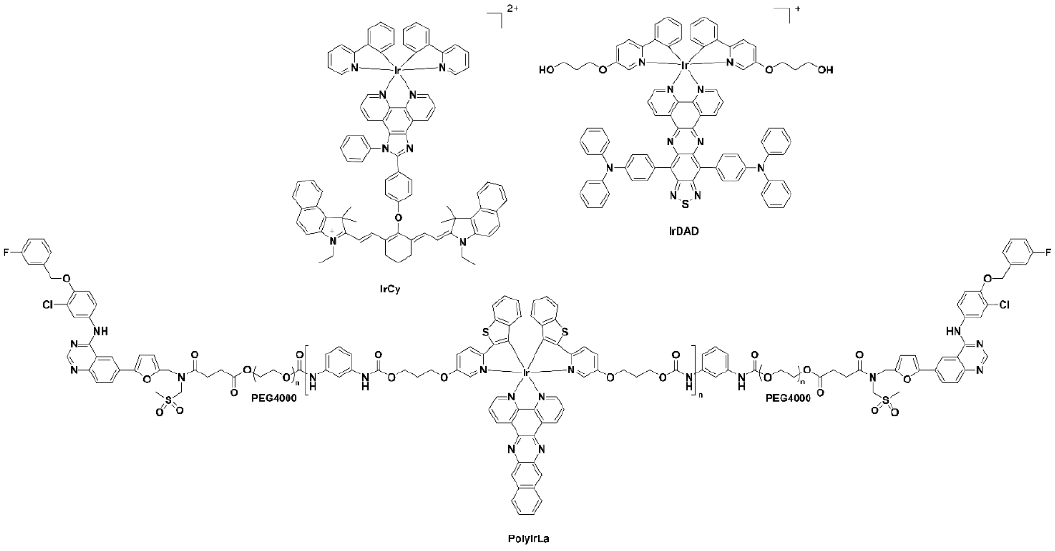
Figure 8. Chemical structures of the iridium(III) complexes IRCY, IRDAD and PolyIRLA.